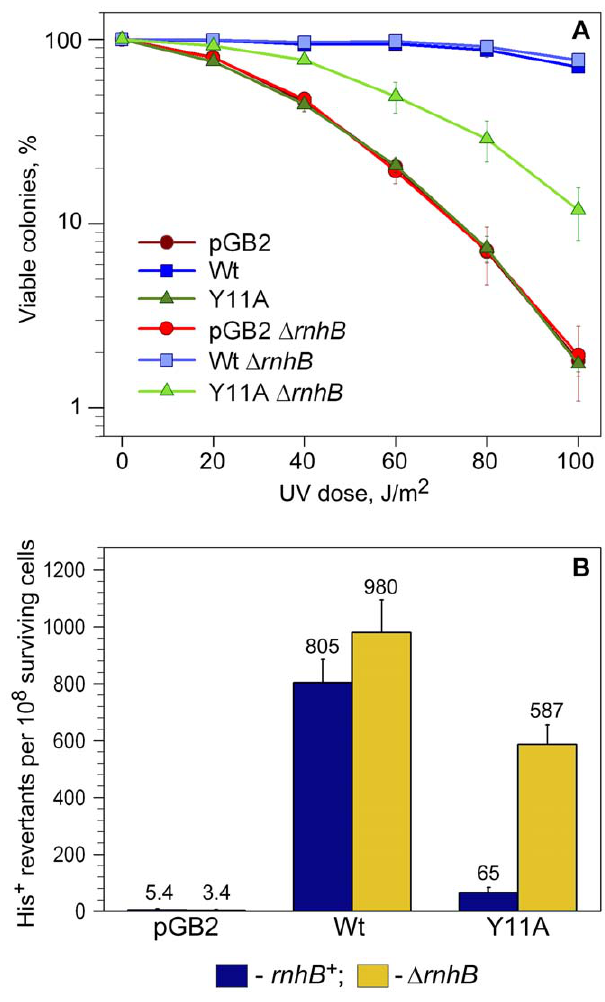
Figure 2. Quantitative UV survival and mutagenesis assays. A: Survival. Exponentially growing cells were exposed to various doses of UV-light and serial dilutions spread on LB plates containing spectino- mycin. The number of viable colonies was determined after overnight incubation at 37 u C. Error bars indicate the standard error of the mean. Consistent with the semi-quantitative UV-survival assay shown in Figure 1, UV-resistance of strains expressing Y11A_UmuC increased significantly in the D rnhB background, while there was no change in UV-survival of the strain harboring vector, pGB2, or expressing wild- type pol V in the rnhB + / 2 strains. B: Mutagenesis. UV-induced mutagenesis was determined by exposing exponentially growing cells to 20 J/m 2 UV light. Cell viability was in the range of 85–90% survival for wild-type pol V and , 60–70% for vector control, pGB2, and the Y11A mutant. The average number of His + revertants per 10 8 surviving cells 6 standard error of the mean is indicated on the graph. The rnhB + strains are indicated by navy-colored bars, while D rnhB strains are indicated by the gold-colored bars. As observed, the UmuC_Y11A-expressing cells exhibited an , 9-fold increase in UV mutagenesis compared to the rnhB + strain.